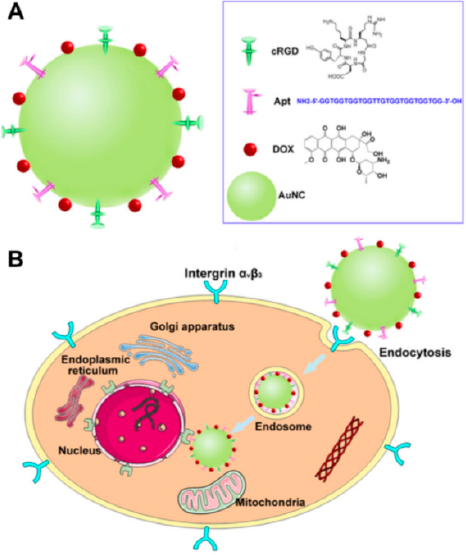
Figure 6. ( A ) Diagram of functionalized AuNCs, ( B ) Schematic illustration of dual targeting AuNCs for tumor imaging and therapy. Reprinted with permission [60], Copyright 2016 Elsevier